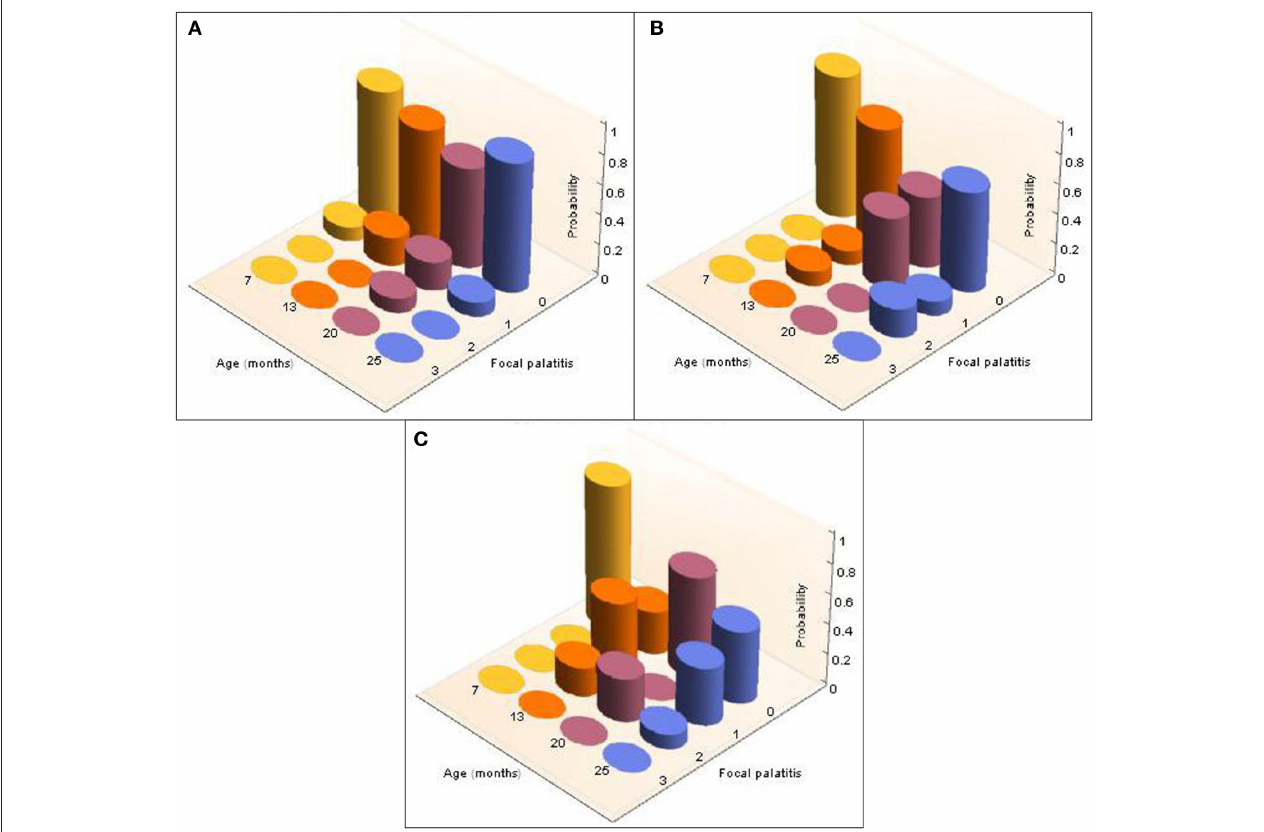
FIGURE 8 | 3-D column charts depicting the longitudinal development, and severity of, FP in the five cheetah cubs from the Ann van Dyk cheetah centre followed from 7 months to 25 months of age. The probabilities of finding FP present in each of the palatal depressions that can potentially have FP are indicated as a function of age (months). Note that dRPM2 and dLPM2, dRPM3 and dLPM3, and dRPM4 and dLPM4 were pooled. (A) Shows FP at the depressions palatal to the maxillary 2nd premolar teeth, (B) shows FP at the depressions palatal to the 3rd maxillary premolar teeth, (C) shows FP at the depressions palatal to the 4th maxillary premolar